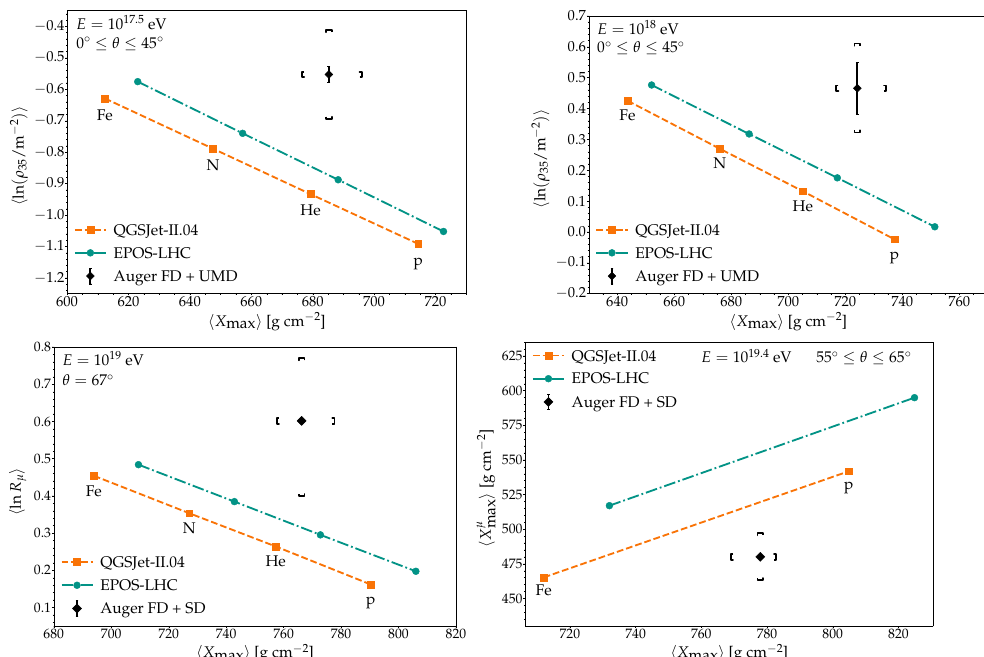
Figure 11. Top panels: Mean value of the logarithmic muon density at 450 m from the shower axis for a reference zenith angle of 35 ◦ as a function of the mean value of X max measured by the Auger UMD. Adapted from [77]. Bottom left panel: Mean value of the natural logarithm of R µ as a function of the mean value of X max measured by the Auger water-Cherenkov detectors. Adapted from [76]. Bottom right panel: Mean value of X µ max parameter as a function of the mean value of X max measured by the Auger water-Cherenkov detectors. Adapted from [88]. The curves correspond to the predictions obtained for EPOS-LHC and